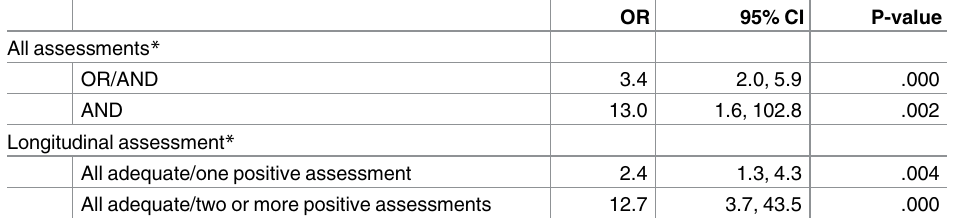
Table 5. The likelihood that additional actions were taken by the child health nurses when an infant performed outside the cut-off for Structured Observation of Motor Performancein Infants.